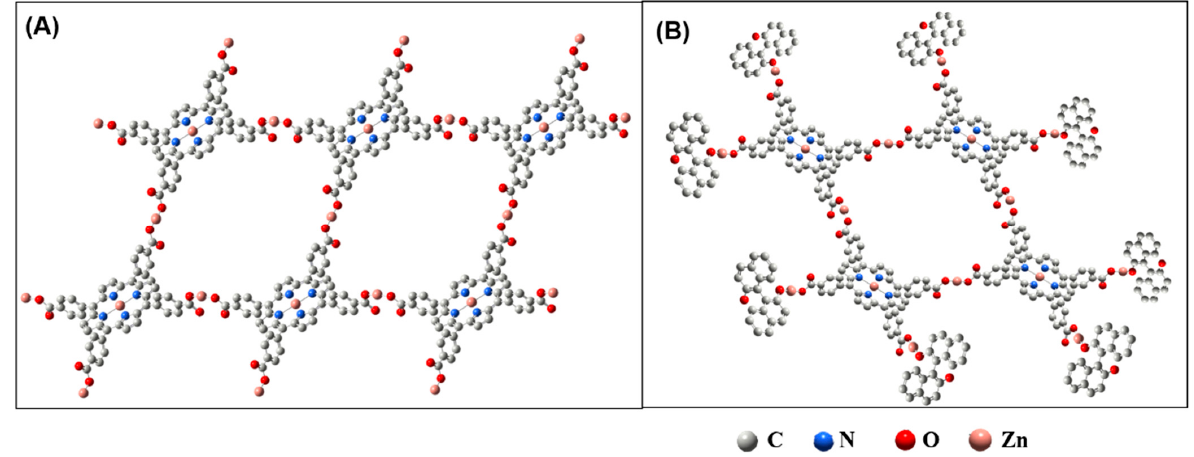
Scheme 2. Schematic illustrations for the structure of ( A ) TCPP-Zn and ( B )